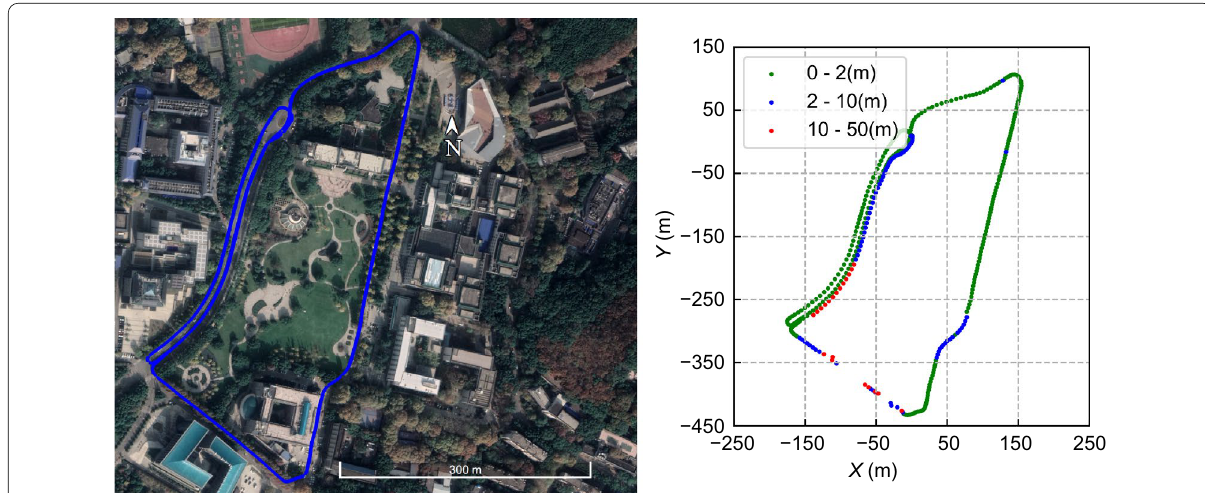
Fig. 5 Field test trajectory. Left: top view of the trajectory on google earth; right: positioning result of PPP when using multi-GNSS data in GNSS partly-blocked